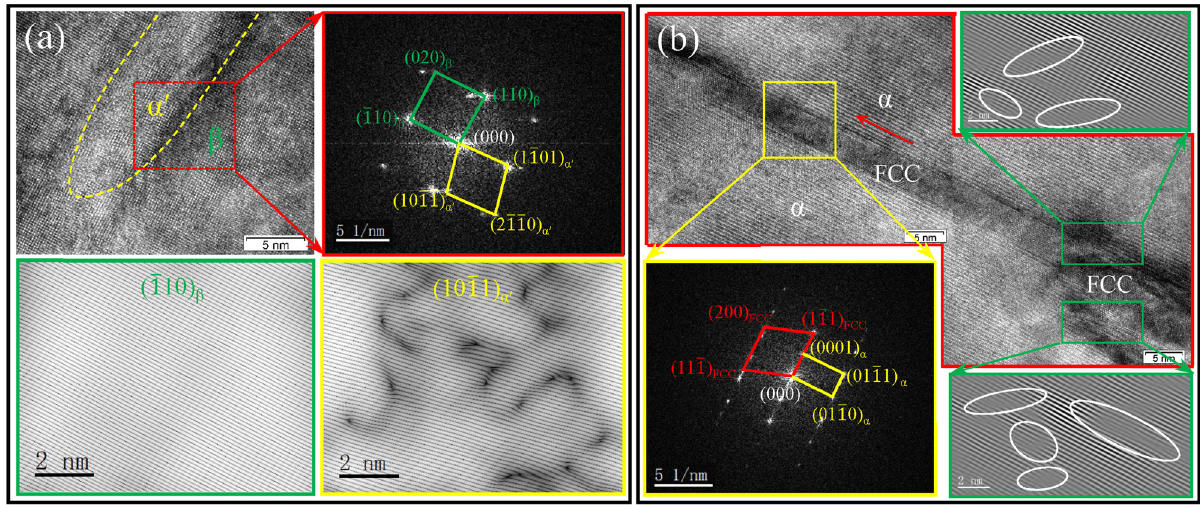
Figure 6: TEM micrographs of the yellow and red rectangle region in Figure 5 ( a ) : ( a ) the HRTEM image FFT pattern, ( 01 ¯ 10 ) α ′ and ( 1 ¯1 0 ) β lattice fringes of ( α ′ + β ) region, ( b ) the HRTEM image, FFT pattern, and ( 11¯1 ) FCC lattice fringes obtained by fi ltering of ( FCC + α )